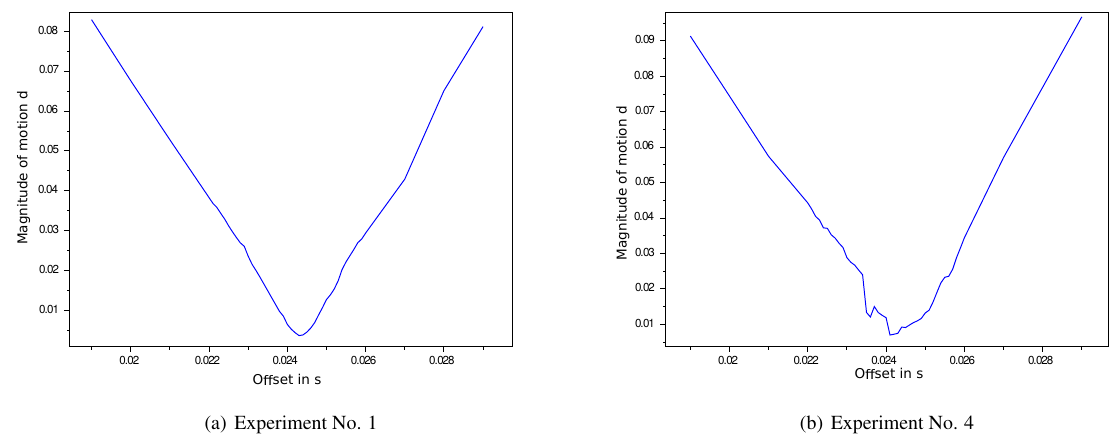
Figure 4. Results generated by the approach to calculate timestamp offsets prior to data acquisition. The measurement graphs belong to experiments whose results are depicted in Table 1.